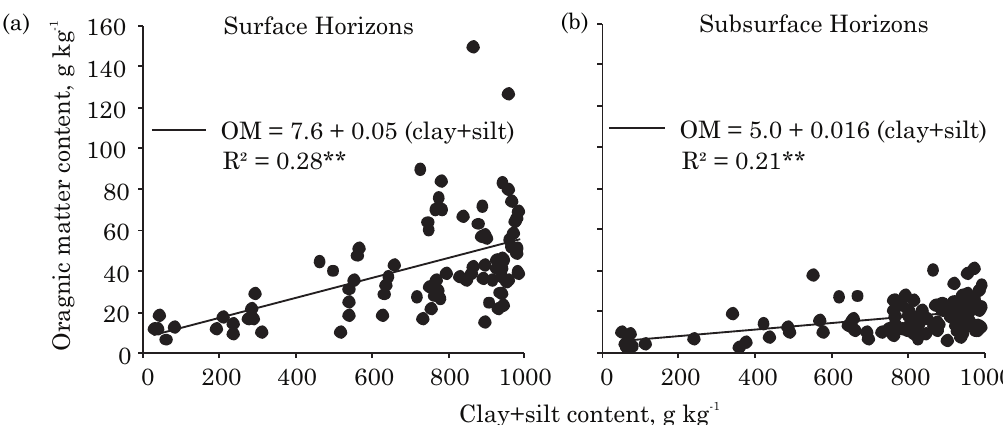
Figure 1. Relation between organic matter (OM) contents with the clay+silt contents for the surface (a) and subsurface (b) horizons of the soils of the State of Santa Catarina. ** model significant at 1